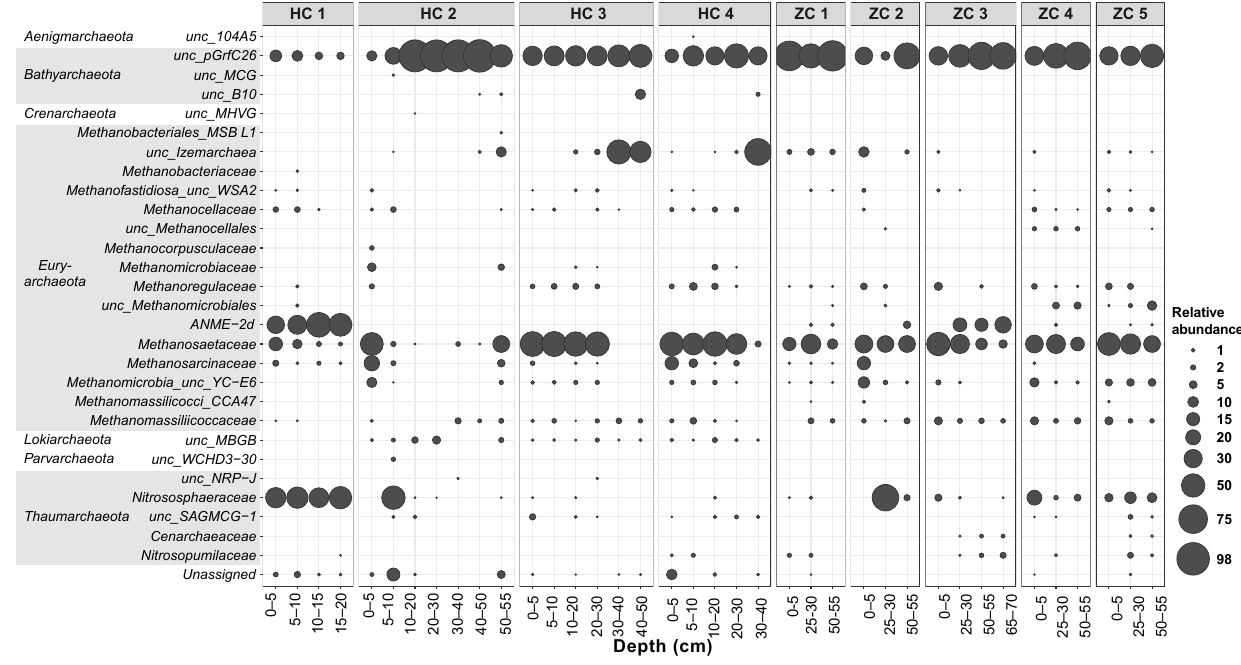
Figure 5. Relative abundances of different archaeal lineages in the study sites. Along the horizontal axis samples are arranged according to site and depth. The rank order along the vertical axis is shown for the family level. If an assignment to the family level was not possible, the next higher assignable taxonomic level was used.